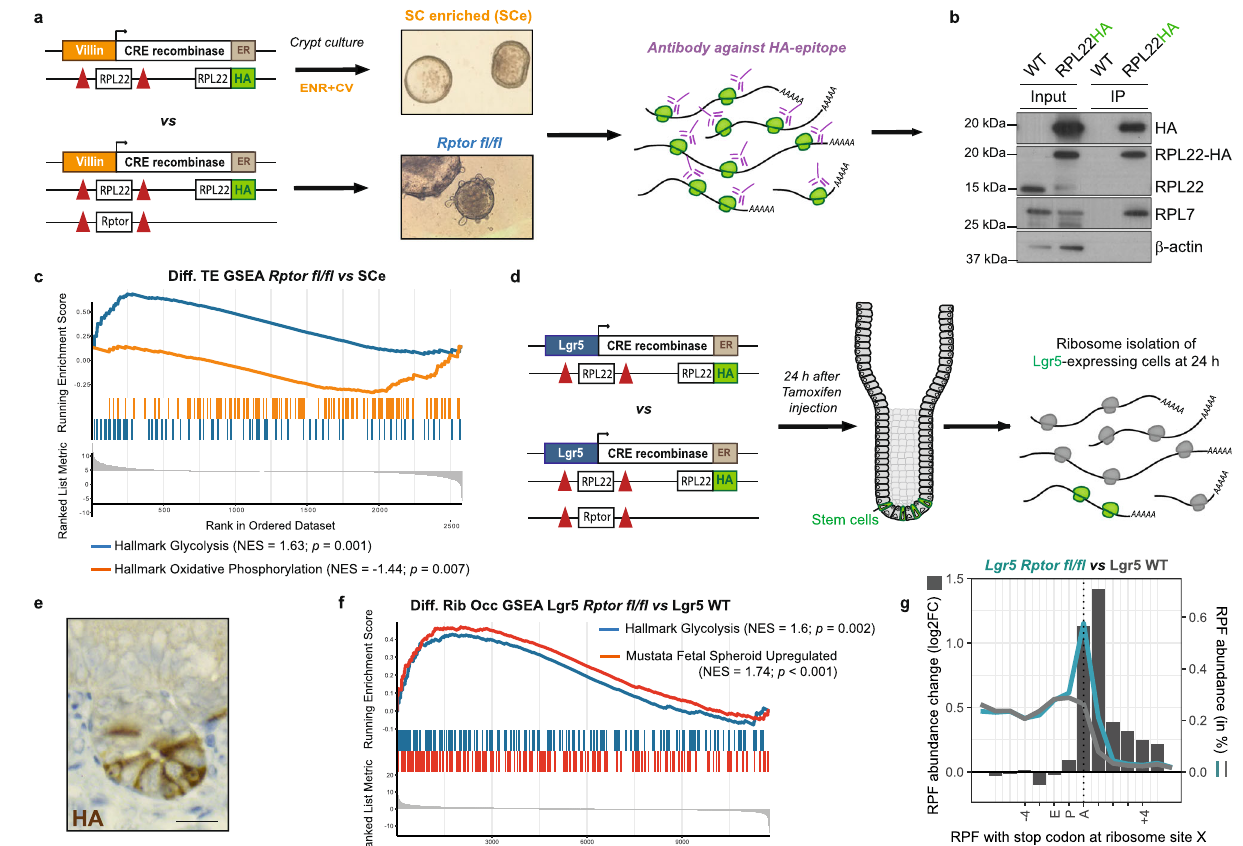
Fig.2|Metabolismistranslationallyregulatedinfetal-likeISCs.a Experimental work fl ow of the RiboSeq experiment comparing the translatome of Rptor fl / fl orga- noids to WT. Crypt cultures were generated from VillinCre ERT2 RPL22.HA mice